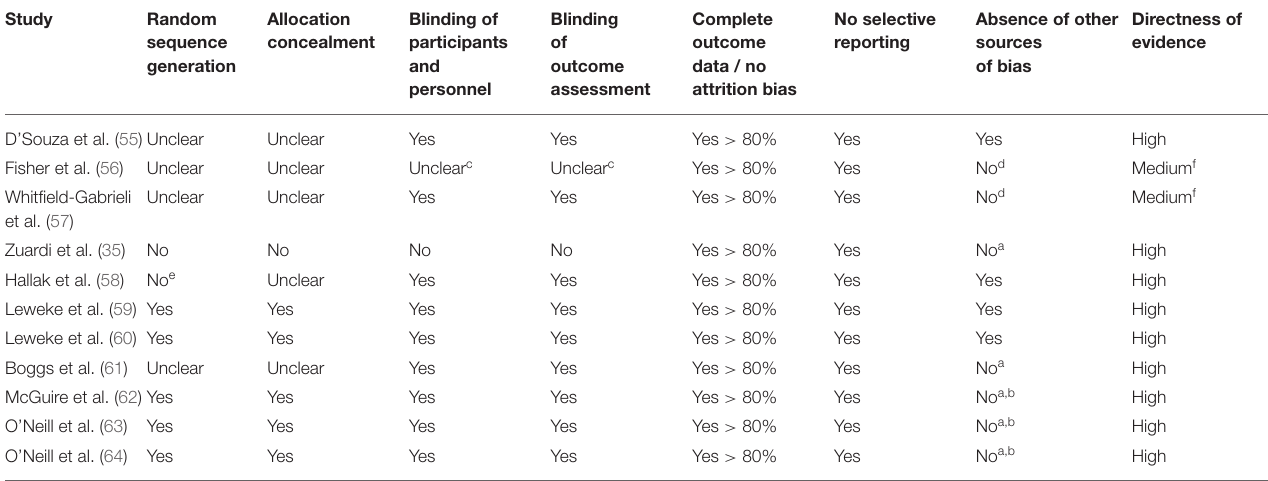
TABLE 2 | Study quality and assessment of potential for bias. Study Random